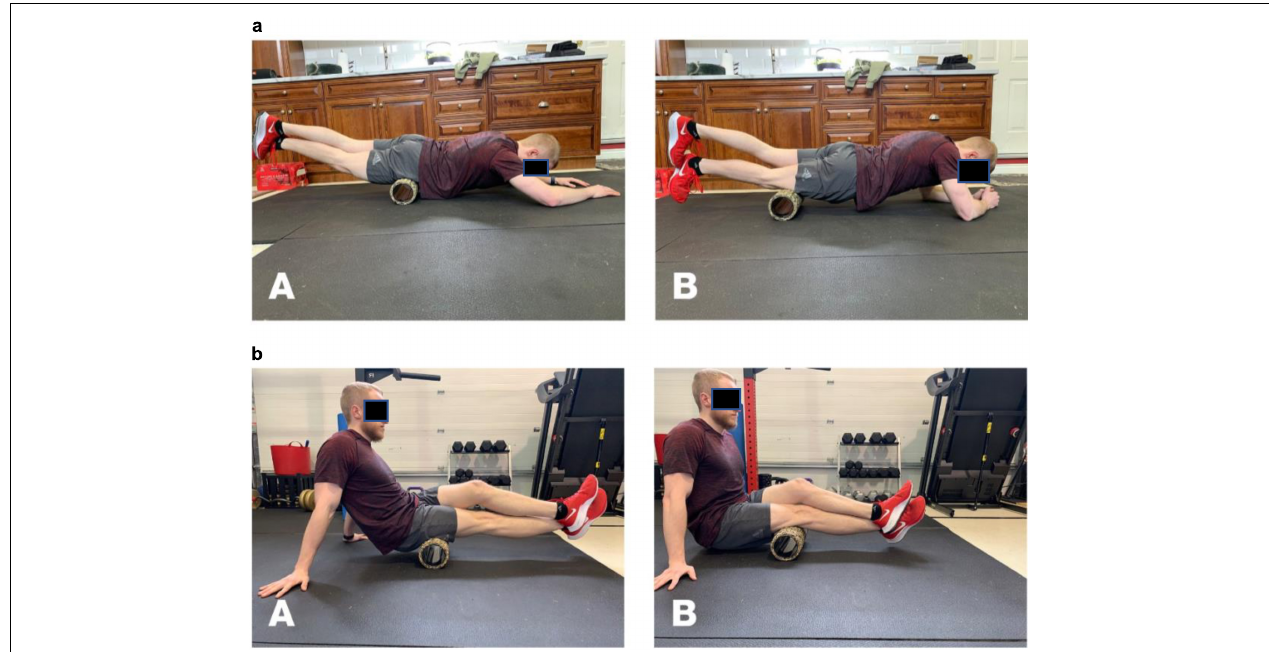
FIGURE 1 | (a) Quadriceps foam rolling protocol. Starting position at proximal quadriceps (A) and end position at patella (B) . (b) Hamstrings foam rolling protocol. Starting position at proximal hamstrings (A) and end position at popliteal fossa (B)